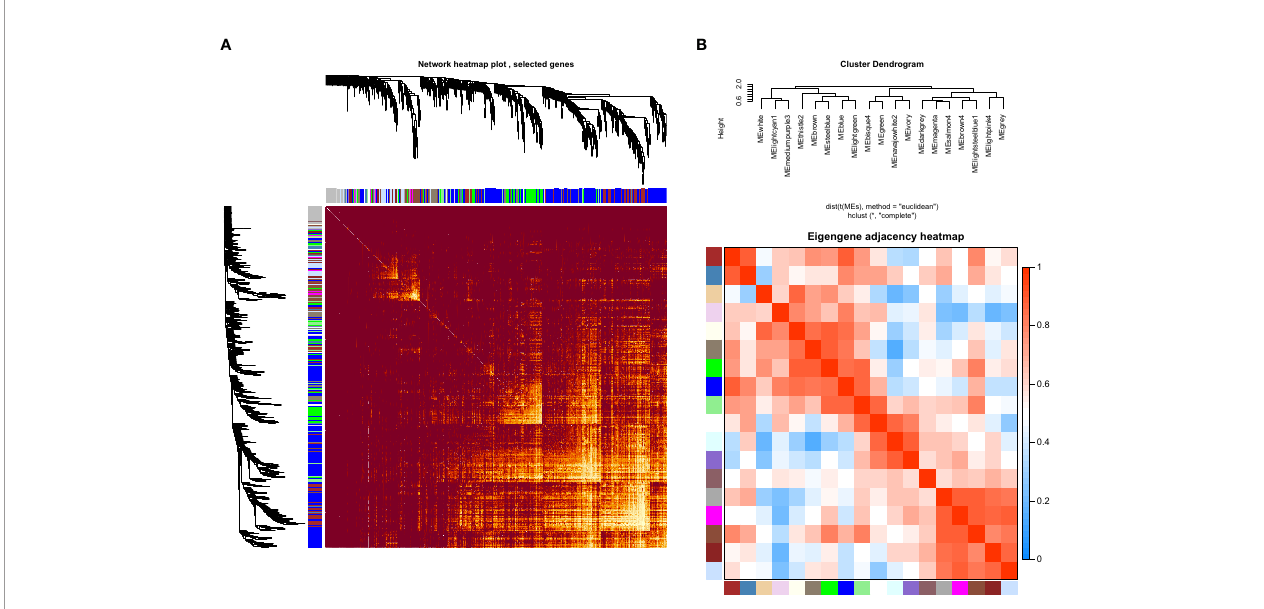
FIGURE 8 | Network heatmap plot and clustered correlation. (A) The degree of correlation within the module. Different colors of horizontal and vertical axes represent different modules. The bright yellow in the middle of the plot represents the degree of connectivity between different modules. There was no signi fi cant difference in the interactions among the different modules, indicating a high-scale independence degree among these modules. (B) Eigengene adjacency